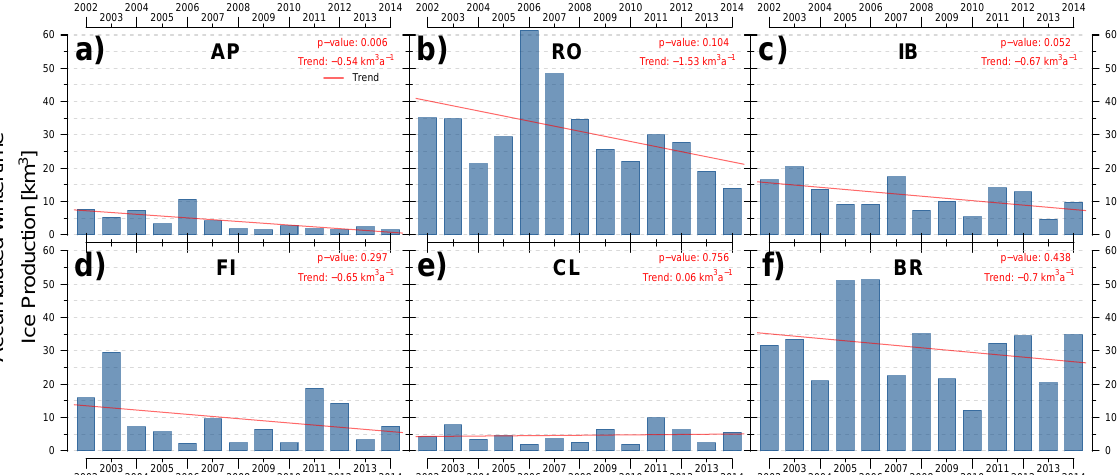
Figure 8. Accumulated wintertime ice production (IP, km 3 ) for the years from 2002 to 2014 during the winter period from April to September. The red line indicates the multi-year regional trend (km 3 a − 1 ). p value and numeric trend are stated in the top right corner for each subregion.